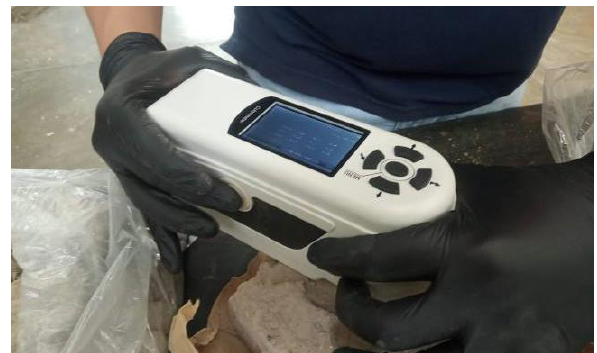
Figure 10. Use of the colorimetry equipment in an adobe sample. Photo: David Preciado Villicaña (2019). © SPOT Image Copyright 2020.